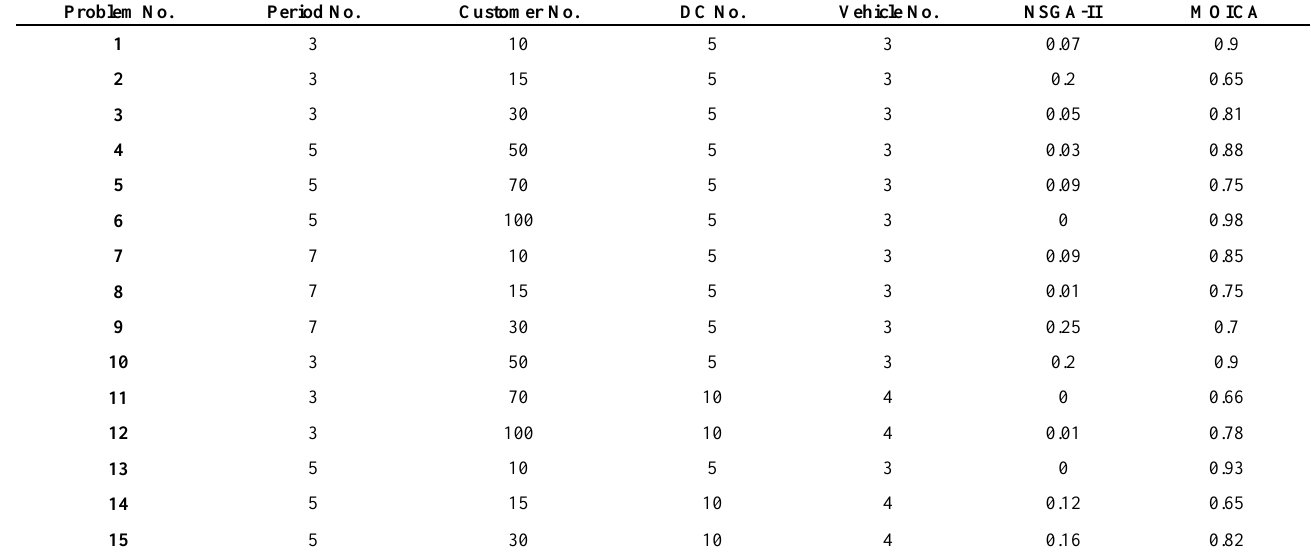
Table 3. Comparison results between the NSGA-II and MOICA according to the QM. Problem No.